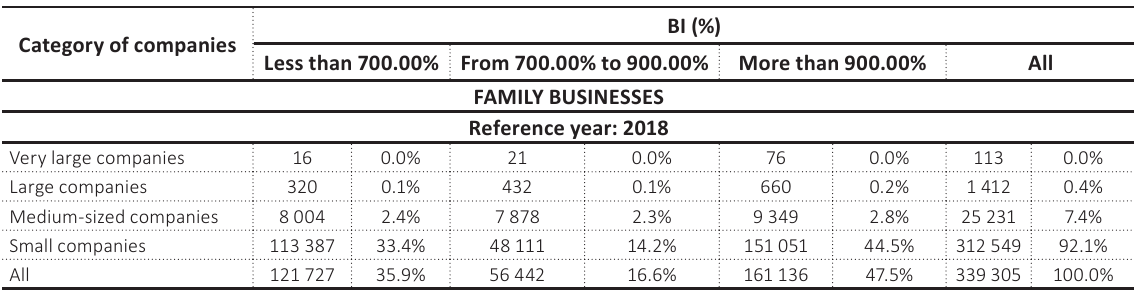
Table 6. Bankruptcy Index values of the total of active Hungarian companies grouped by size and differentiated by